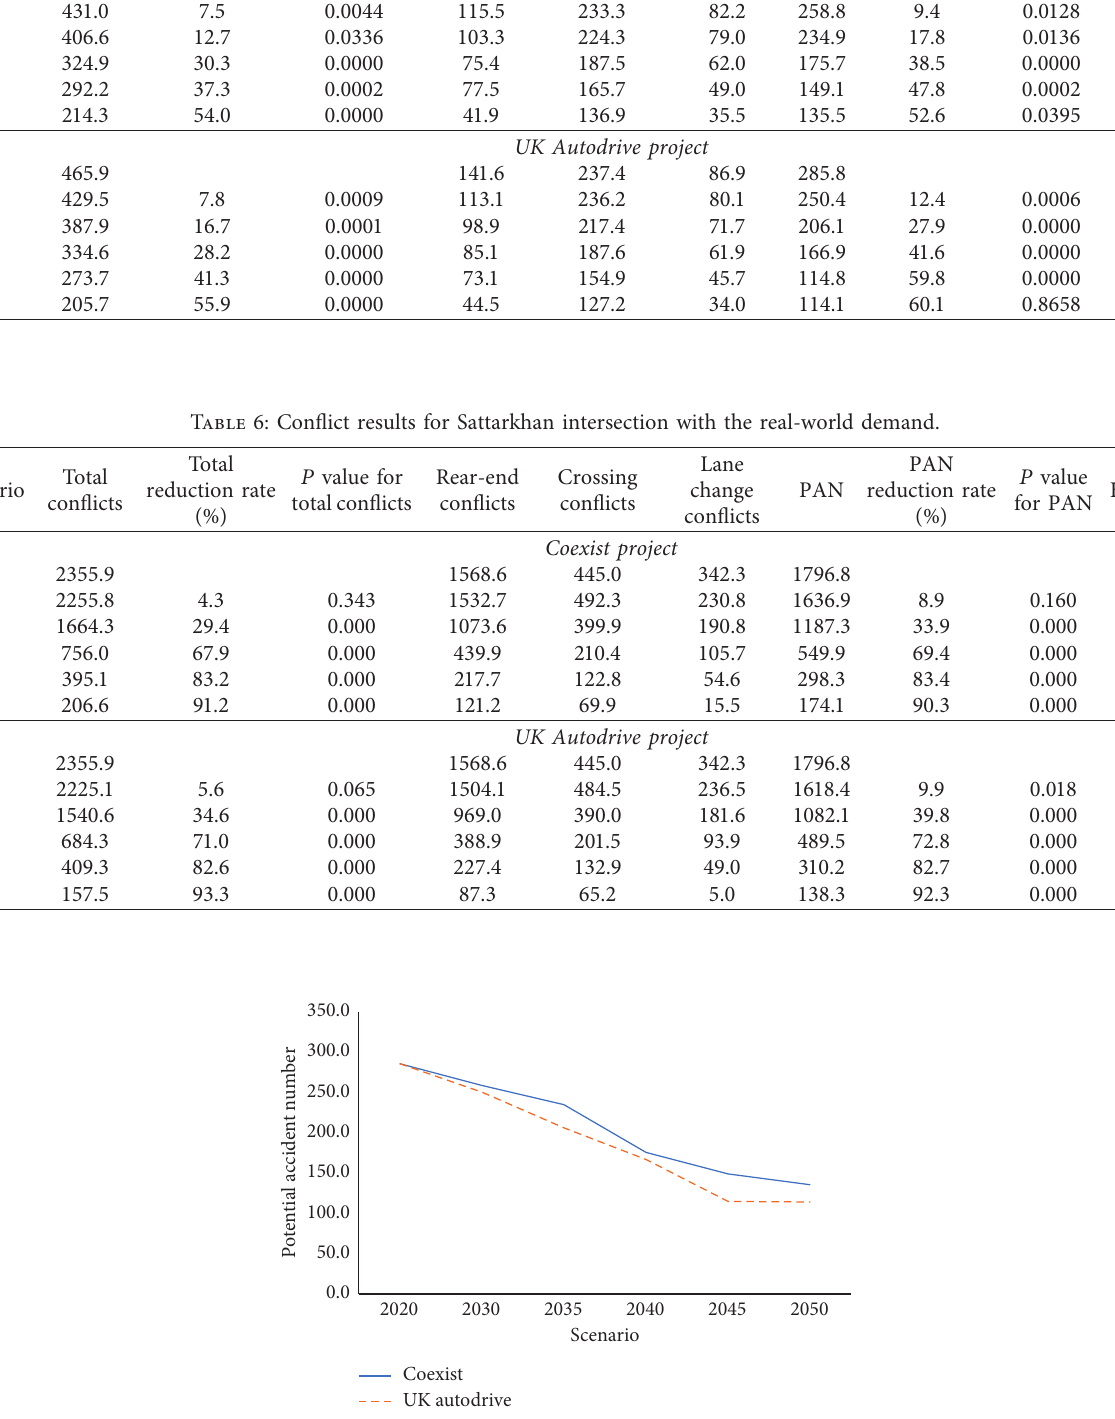
Figure 6: PAN comparison for two projects at the Vesal